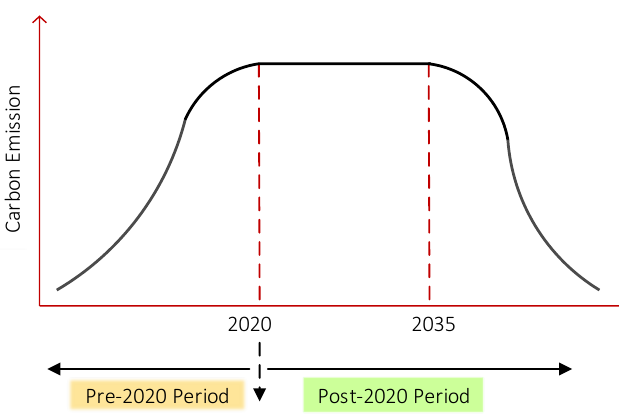
Figure 7. The 2030 agenda for carbon emission pathway.